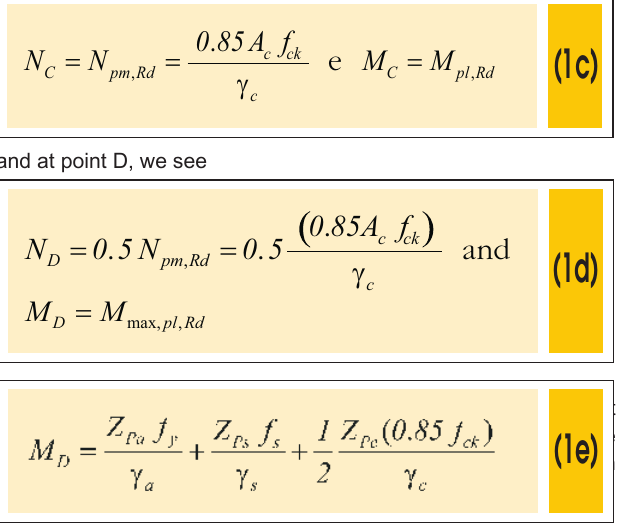
Figure 3 – Interaction curve according